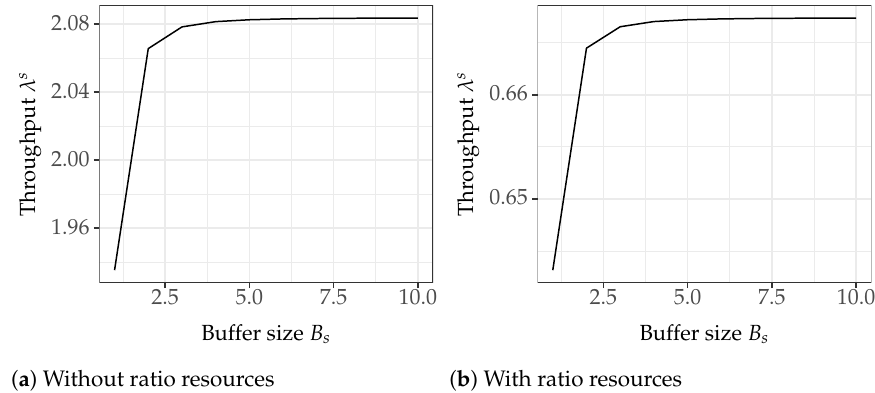
Figure 8. Buffer size schemes versus throughput.